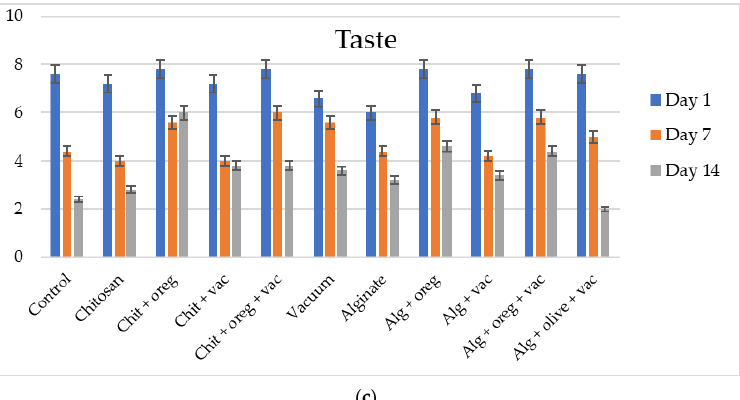
Figure 5. Results of sensory evaluation of meat pieces from the shoulder region over time. (Chit: chitosan coating; oreg: oregano essential oil; vac: vacuum packaging; Alg: alginate coating; olive: olive oil addition) (( a ): tenderness; ( b ): odour; ( c ): taste).